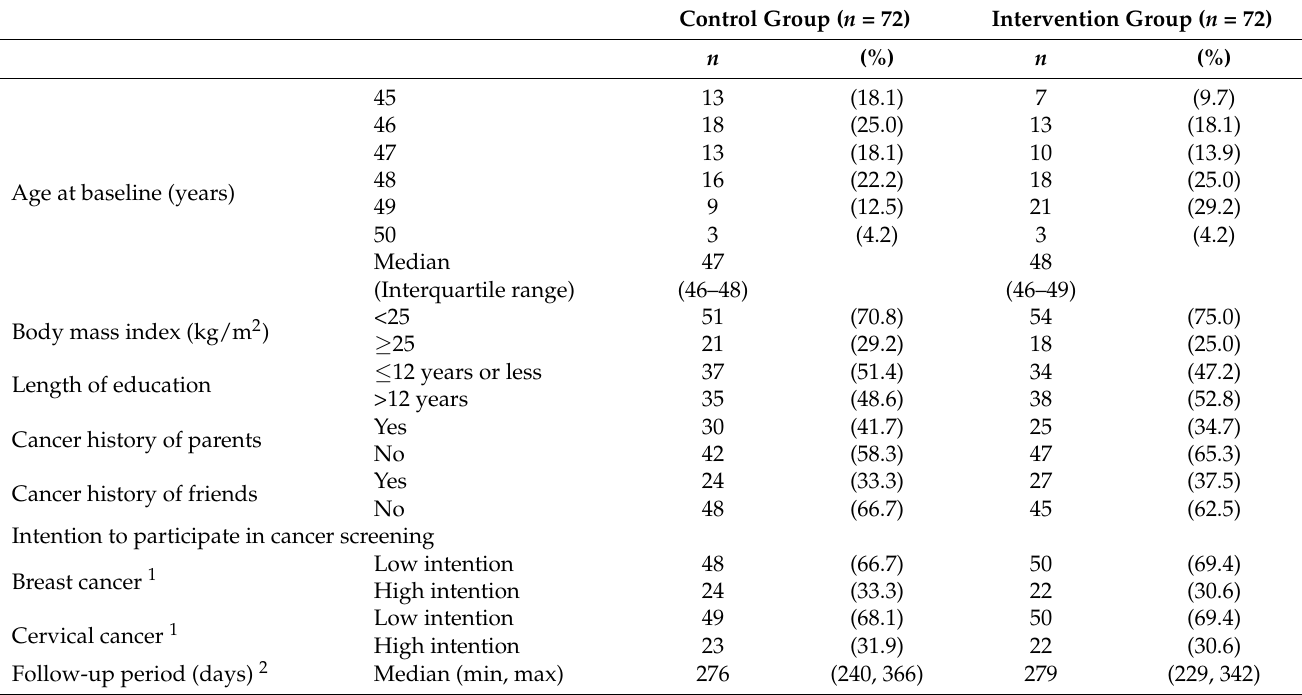
Table 1. Characteristics of study participants in Okazaki, Japan,